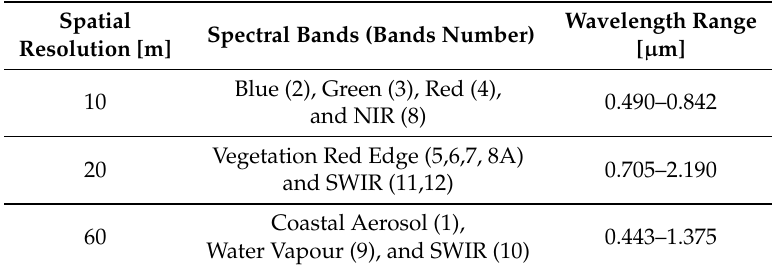
Table 3. The 13 Sentinel-2